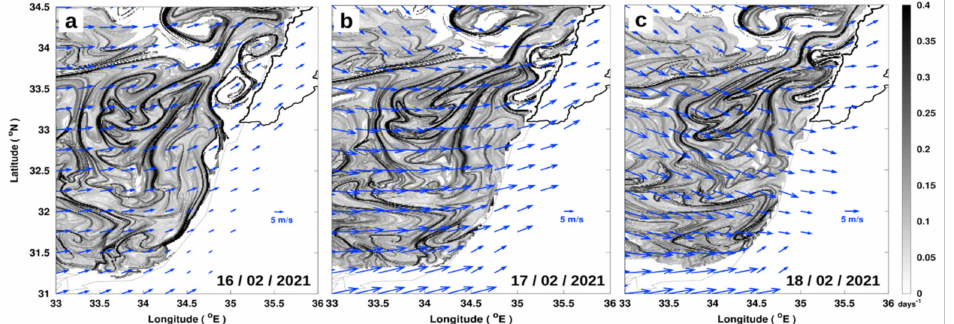
Figure 12. FSLE maps using surface currents corrected with a wind component for the 16–18th of February 2021 in panels ( a – c ), respectively. Wind speed is represented as blue vectors in all the